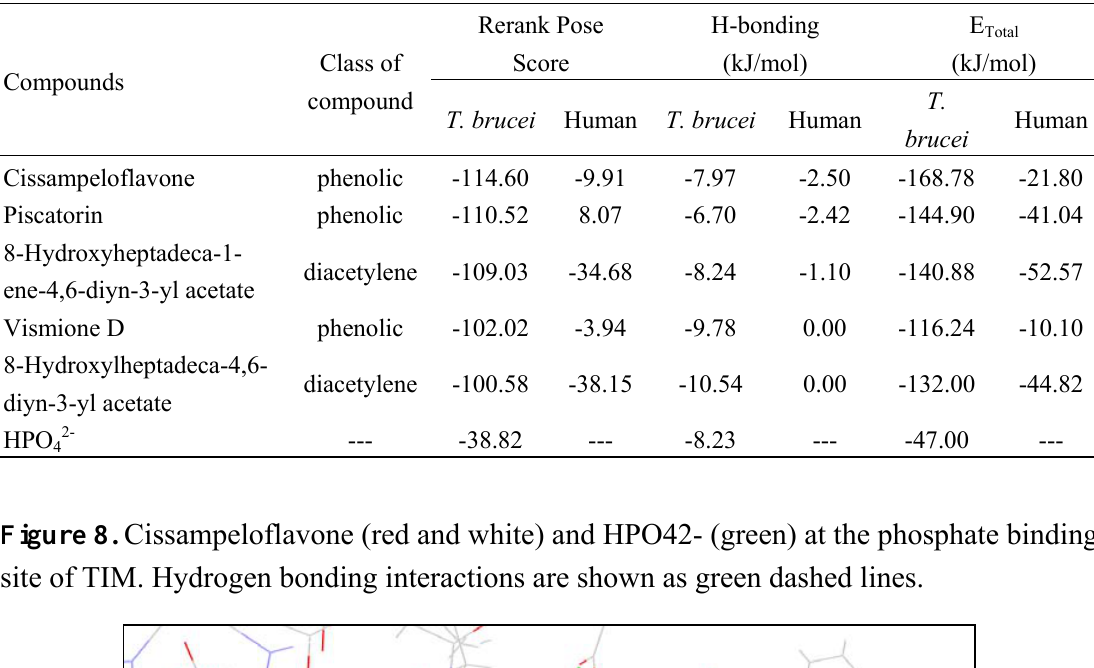
Table 5. Top hit compounds for docking to triosephosphate isomerase (TIM).